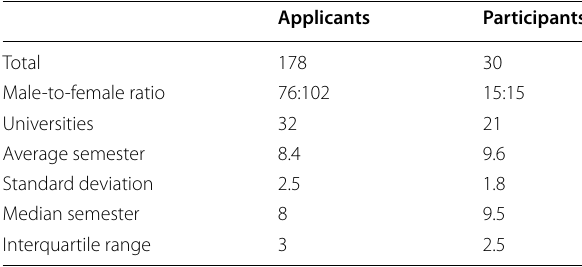
Table 1 General characteristics of applicants and participants